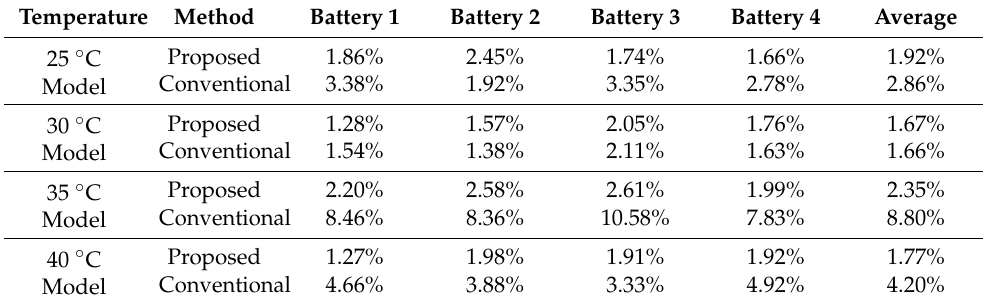
Table 9. The SOC errors obtained using the GBM model generated by the proposed method.